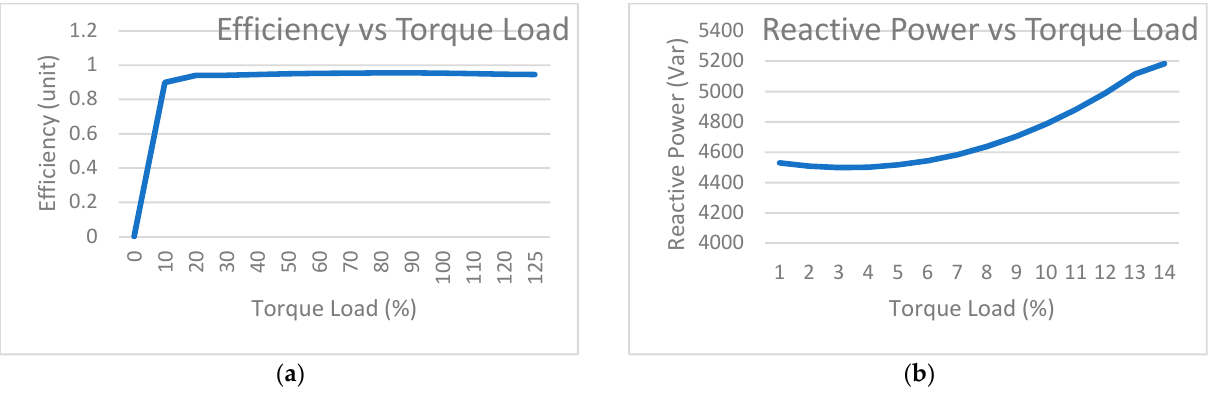
Figure 14. ( a ) Efficiency vs torque load; ( b ) reactive power vs torque load.